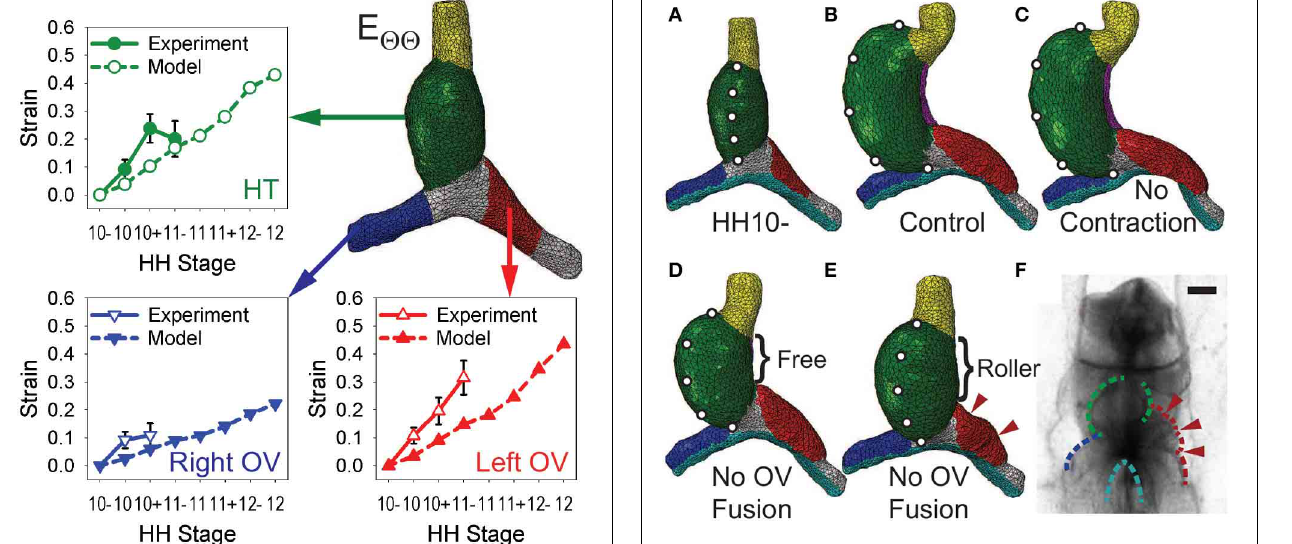
FIGURE 7 | Time history of regional circumferential strains in baseline model. Average circumferential strains ( E ΘΘ ) relative to HH10- in three regions are compared with experimental data from Ramasubramanian et al. (2006). HT, heart tube; OV, omphalomesenteric vein.